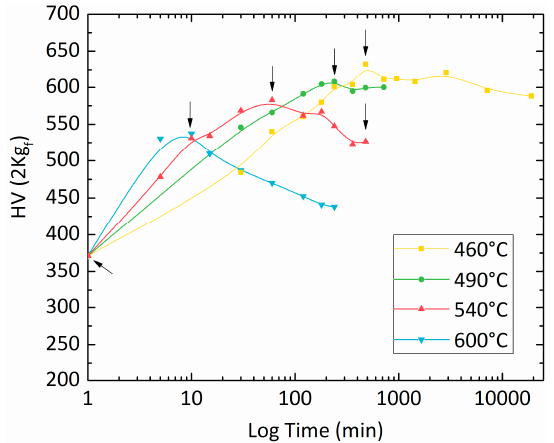
Figure 7. Vickers hardness vs. aging time of as ‐ built samples collected at different aging temperatures. Samples selected for further analyses are marked with arrows.